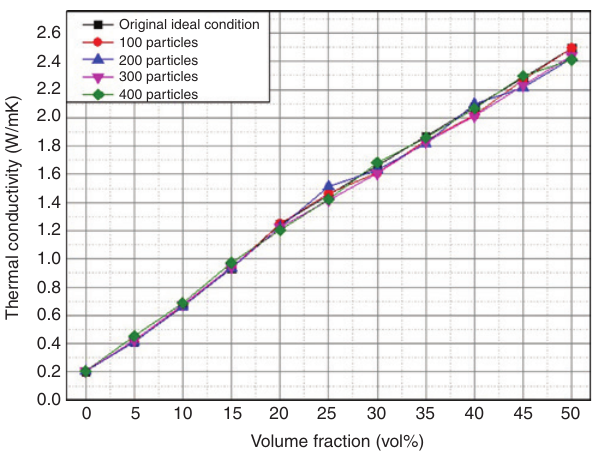
Figure 3: Investigation of the influence from the dependence on particle